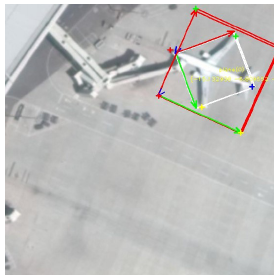
Figure 10. The inner box is not accurate in the DOTA1.0 training dataset, but we get a more accurate box by prediction.